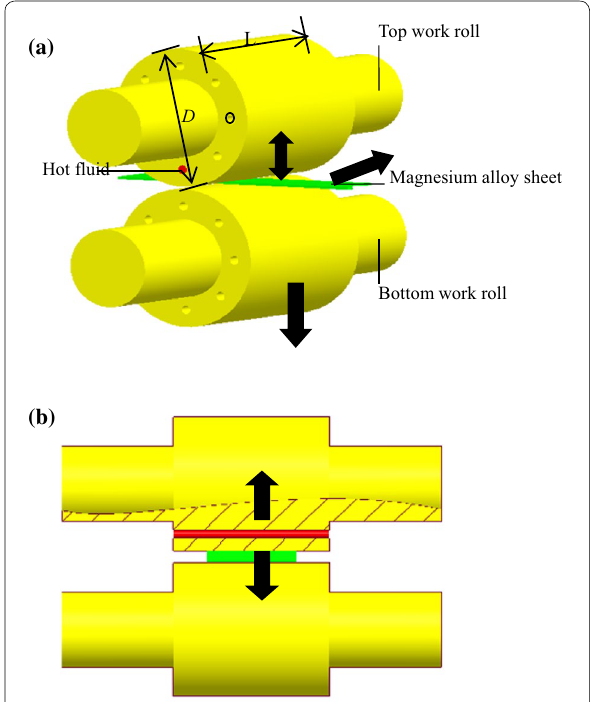
Figure 1 Heat transfer in the process of magnesium alloy sheet rolling